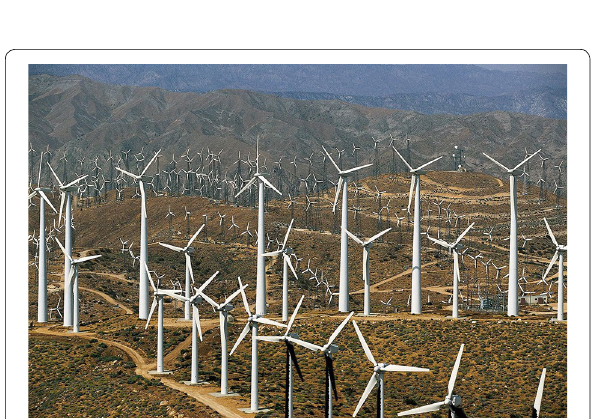
Fig. 1 Wind turbines: exposed and visible (from http://www.yanna rthus bertr